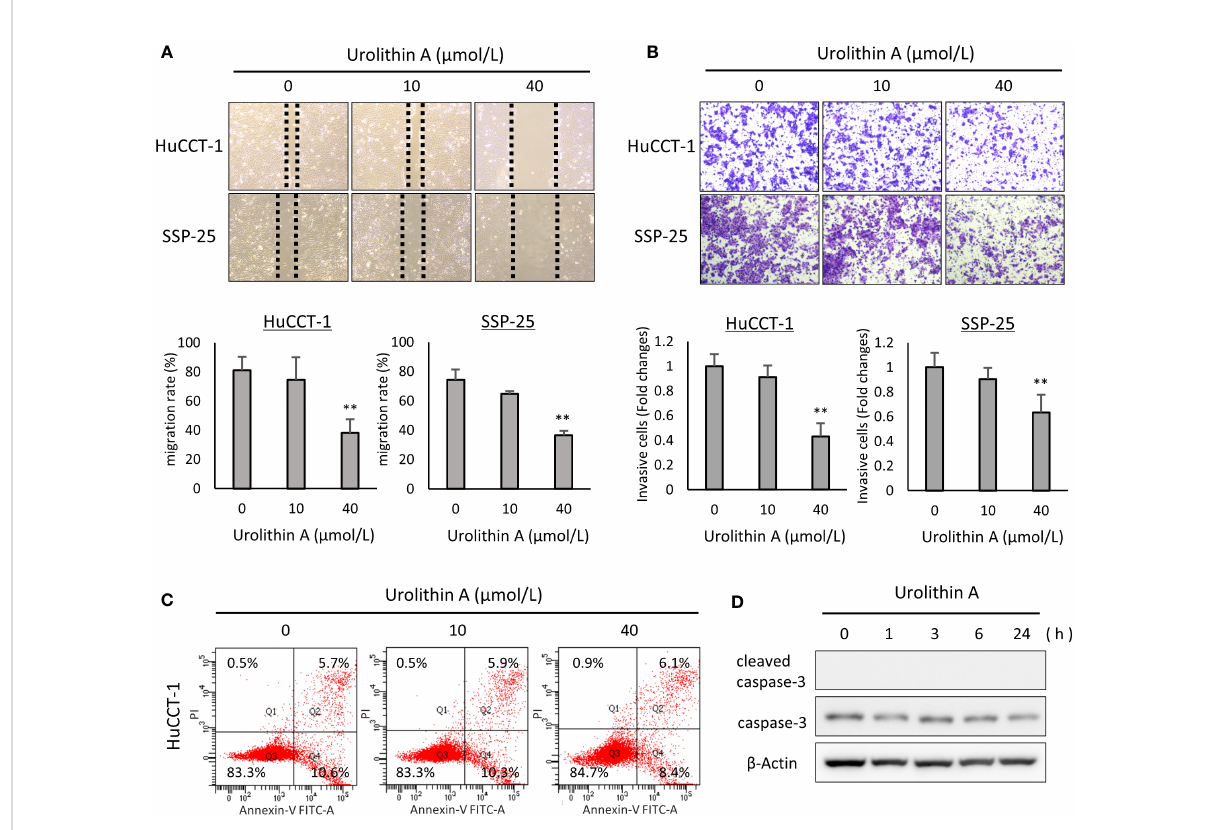
FIGURE 2 Effects of UA on cell migration, invasion, and apoptosis progression in cholangiocarcinoma cell lines. (A) Representative images obtained at 12 h after a scratch wound was made in con fl uent monolayers of HuCCT-1 and SSP-25 cells. After the scratch, 0, 10, or 40 m mol/L of UA were added. The migration rates were quanti fi ed by measuring the area of the injured region. Data represent the means of three independent experiments. Bars, standard deviation; **P < 0.01. (B) Representative transwell-membrane images stained with crystal violet show invasion cells after 12 h of treatment with 0, 10, or 40 m mol/L UA in HuCCT-1 and SSP-25 cells. Quantitative analysis of the invasion cells was expressed as fold change relative to untreated controls. Data represent the means of three independent experiments. Bars, standard deviation; **P < 0.01. (C) HuCCT-1 cells were treated with 0, 10, or 40 m mol/L UA for 24 h, and then stained with annexin-V FITC and PI. Apoptosis cells were evaluated using fl ow cytometry. (D) HuCCT-1 cells were treated with 40 m mol/L UA for 0, 1, 3, 6, or 24 h Expression of apoptosis-related factors was analyzed by Western blotting for cleaved caspase-3 and caspase-3. b -actin was used as an internal loading